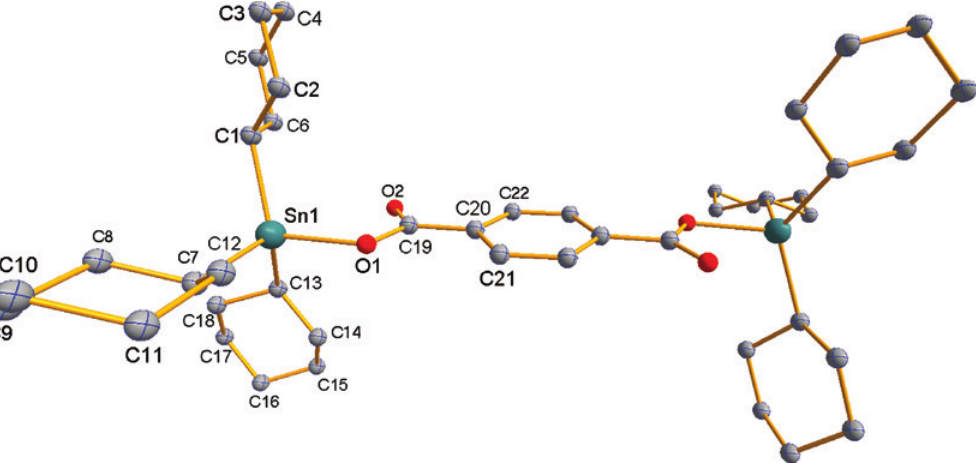
Figure 3: The molecular structure of 3 . Displacement ellipsoids are drawn at the 30% probability level; hydrogen atoms are omitted for clarity. Unlabeled atoms are related to labeled atoms by – x + 1/2, – y + 3/2, – z +